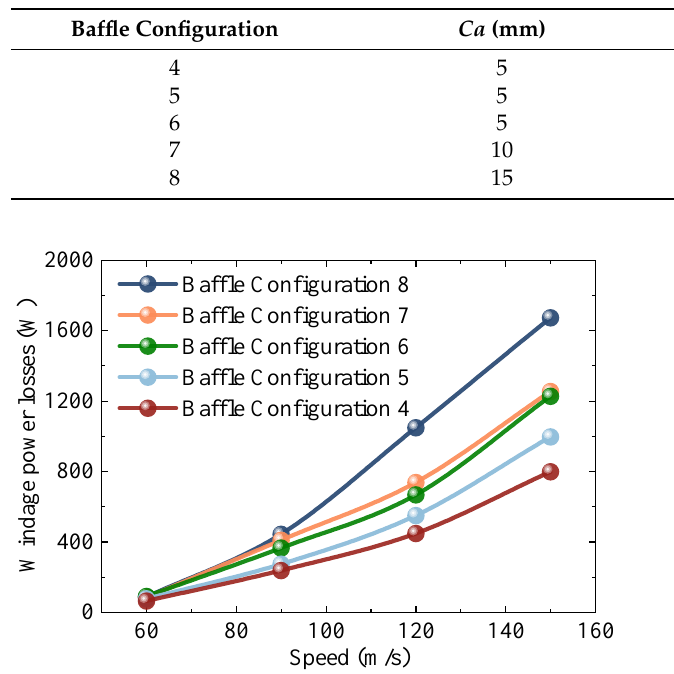
Figure 13. WPL of different baffle clearances.